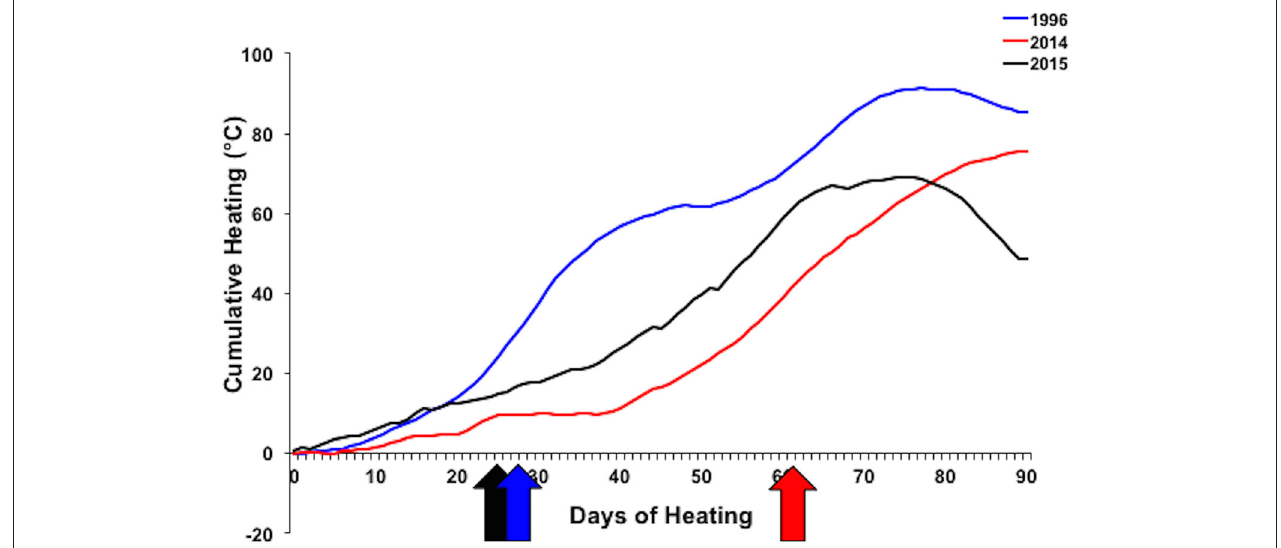
FIGURE 9 | Cumulative heating index for 1996 (blue), 2014 (red), and 2015 (black) bleaching events. Arrows indicate when bleaching began. Temperature data collected from Hawai‘i Institute of Marine Biology Weather Station